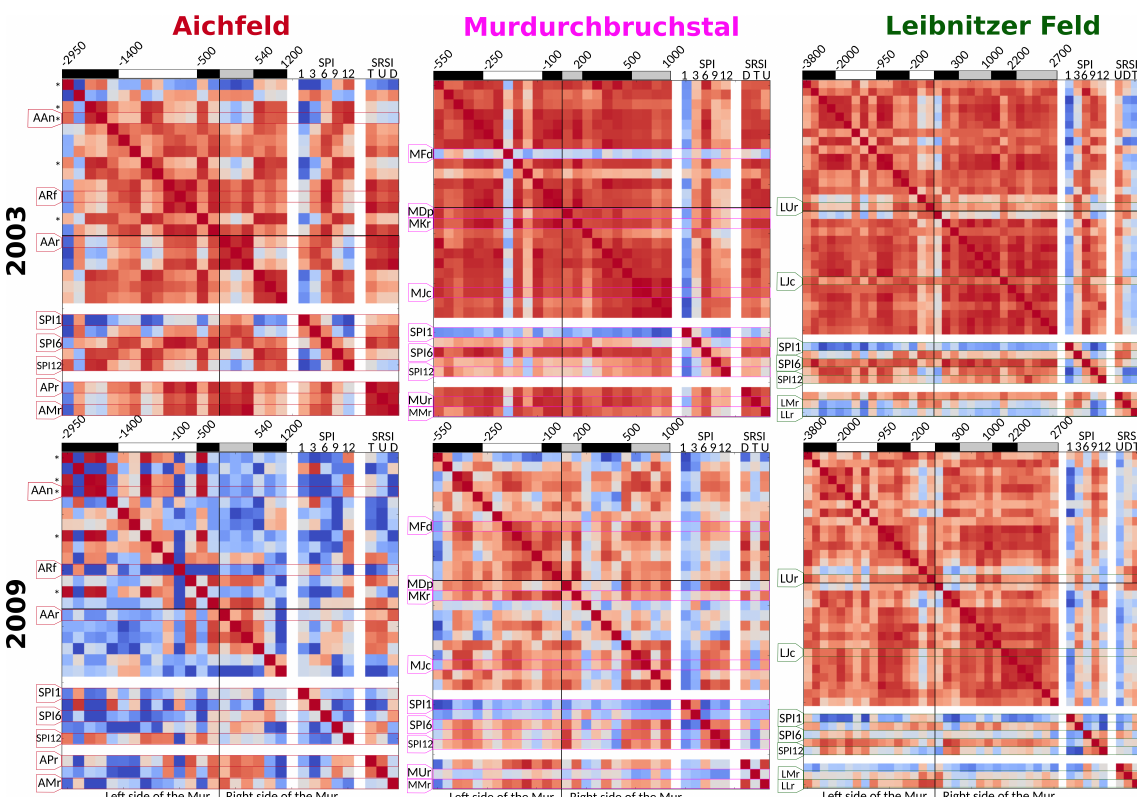
Figure 3. Correlation matrices for the three subregions, showing the effects of the drought year 2003 and the flood year 2009. Legend for the colors and description of the distances; see Fig.